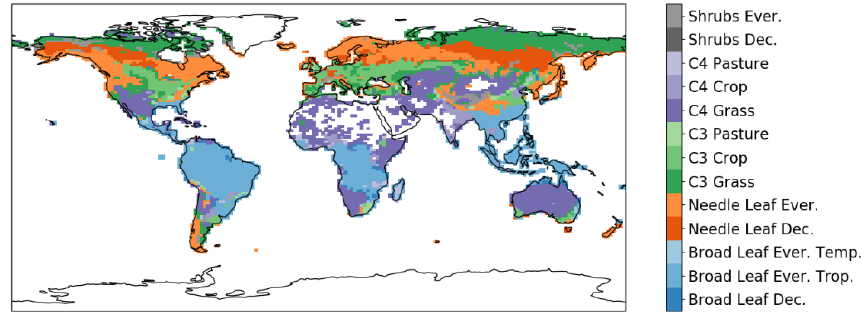
Figure 1. Dominant vegetation PFT per grid box for as prescribed in UKESM1-AMIP